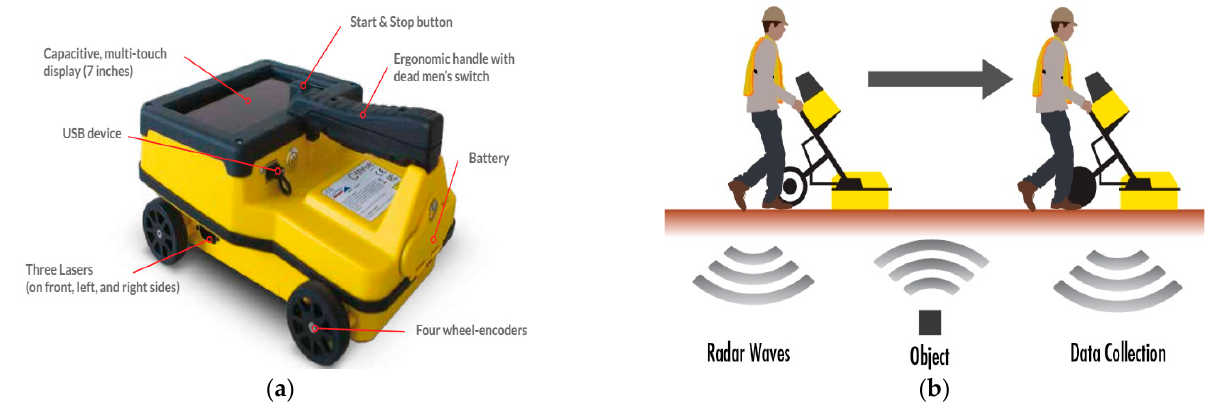
Figure 1. GPR unit and the data collection process [1]: ( a ) Configuration of an GPR unit; ( b ) Field GPR data collection practice.